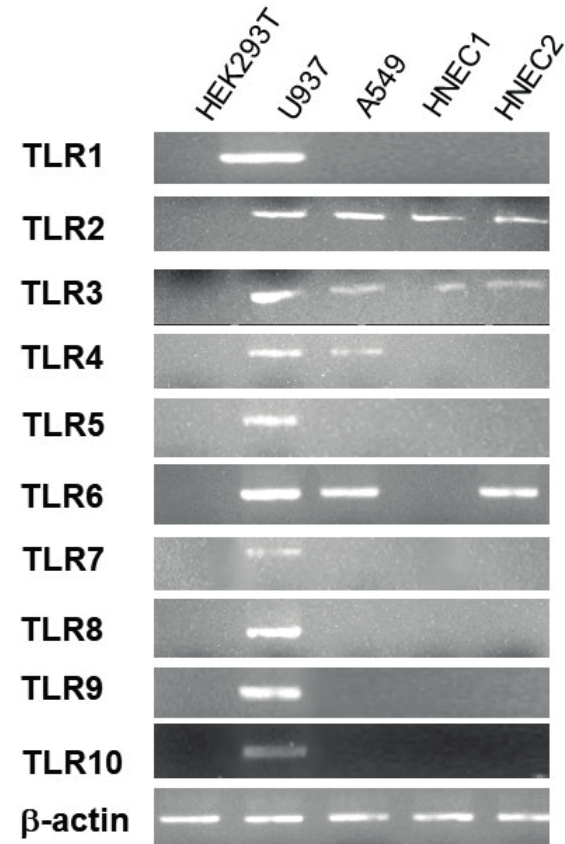
Figure 1. Expression of TLRs in human A549 and HNEC by RT-PCR. Total RNA from both cultured A549, HNEC-1and HNEC-2 were reverse tran- scribed with an oligo(dT) primer, followed by PCR with primers specific to TLR1 to TLR10, or ß-actin (as a loading